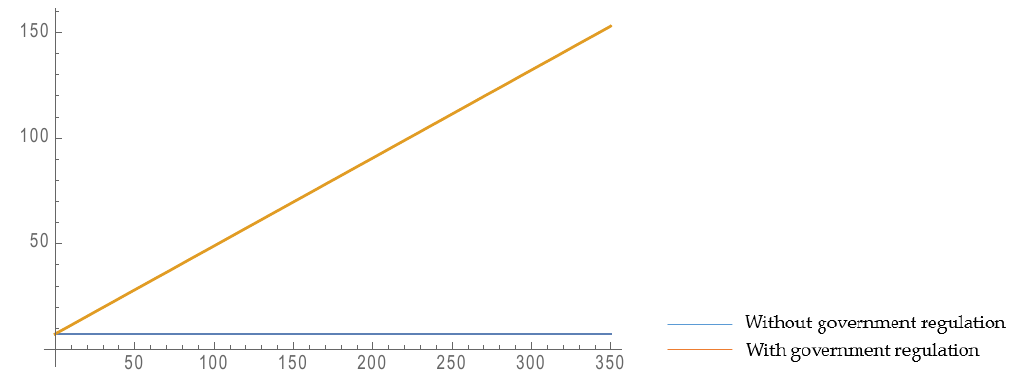
ff ect of ε on the recycling amount in the centralized Figure 7. Effect of  on the recycling amount in the centralized scenario. Figure 7. E